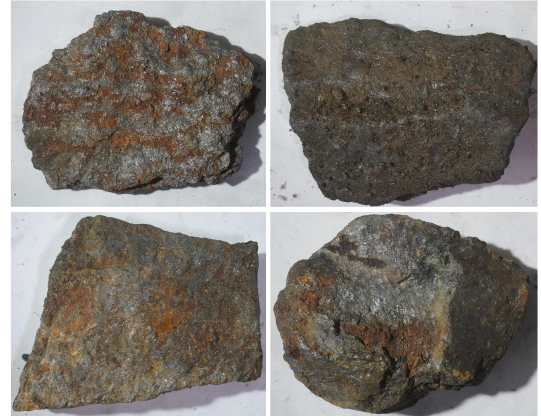
Figure 3. Original image (part).